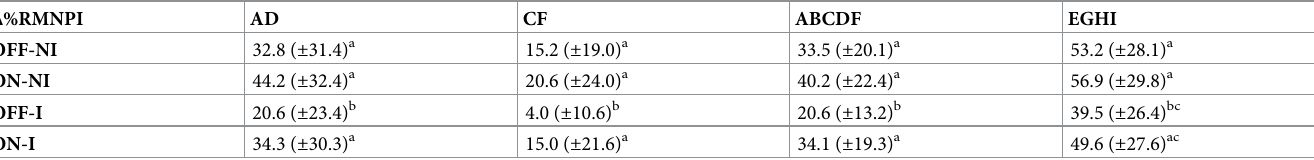
Table 3. Percentage reduction (mean ( ± SD)) of RMNPI values ( Δ %RMNPI) after brushing in selected areas.